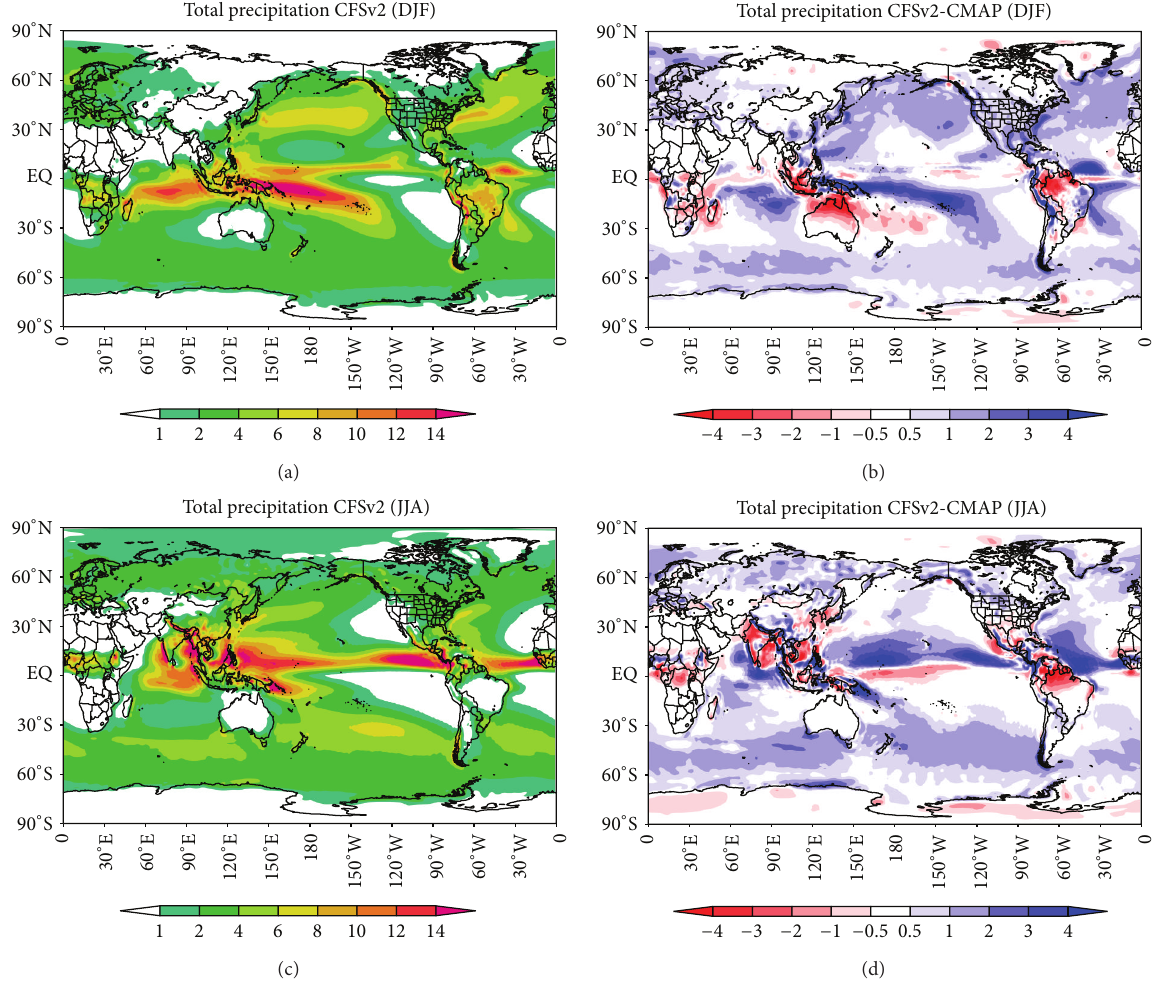
Figure 3: Mean total CFSv2 precipitation ((a) and (c)) and differences from CMAP ((b) and (d)) during DJF ((a) and (b)) and JJA ((c) and (d)) at 0-month lead. The climatology period is 1983–2010. Shaded interval is 2 mm/day from 1mm/day in (a) and (c) and 1mm/day from 0.5 mm/day in (b) and